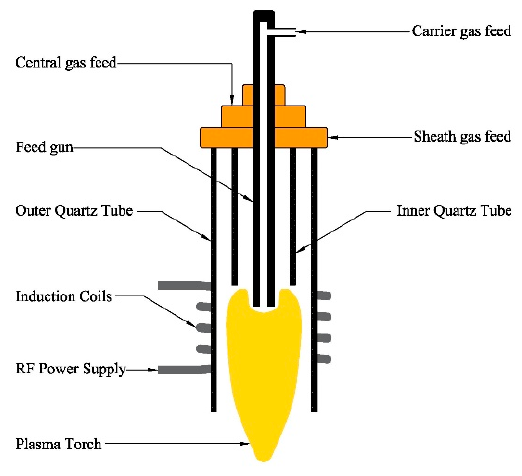
Figure 1. RF thermal plasma reactor.